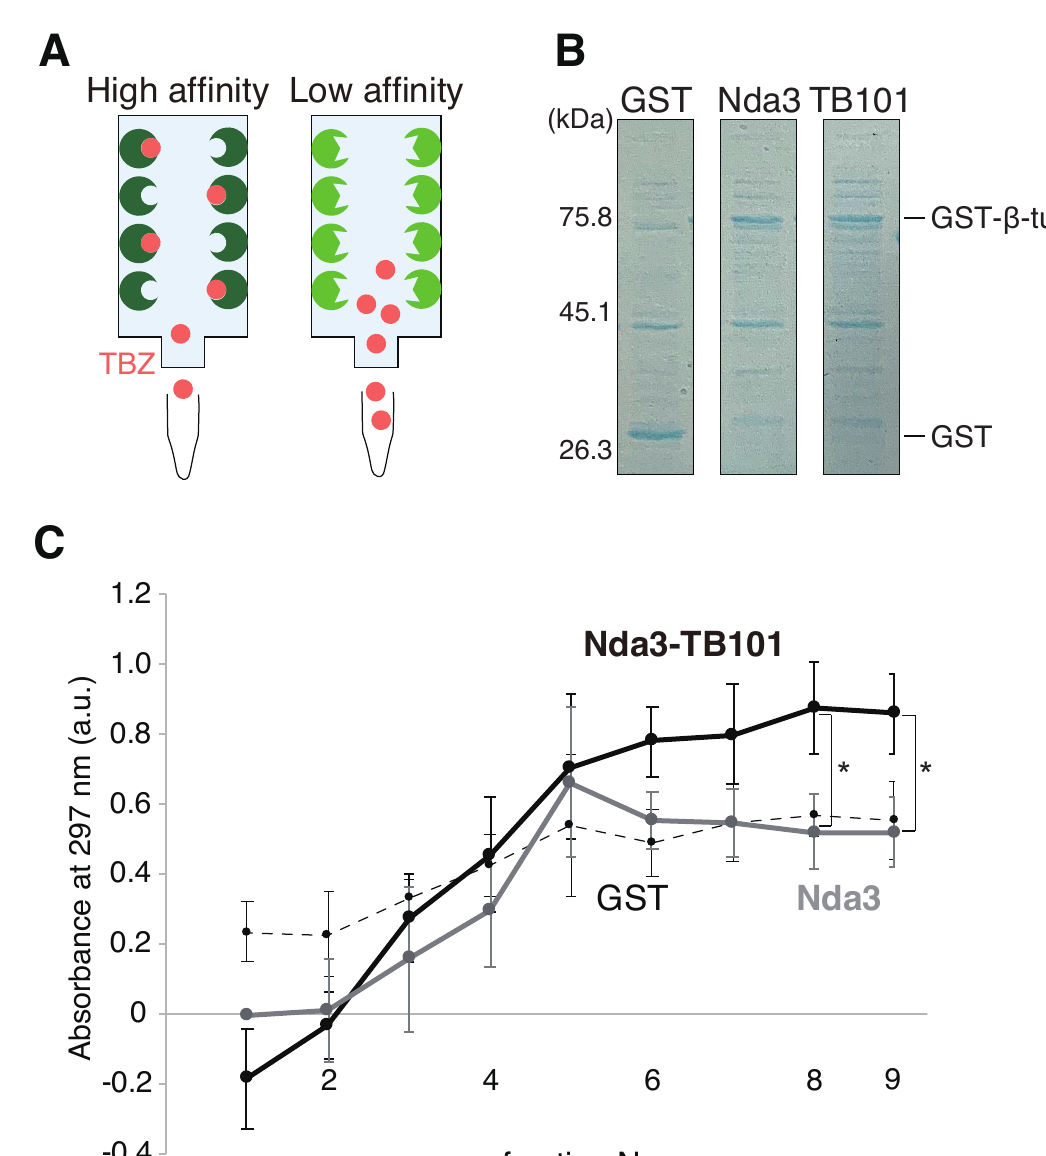
Figure 9. The Y50S mutation of β -tubulin reduces binding affinity to TBZ. ( A ) A diagram for the binding assays. Recom- binant β -tubulin proteins are immobilized in the column and a TBZ solution is applied. TBZ is to be efficiently captured in the column when the affinity between β -tubulin and TBZ is high whilst TBZ will flow through the column when the affinity is low. ( B ) Expression of recombinant proteins Nda3 (WT) and Nda3-TB101 was confirmed by SDS-PAGE followed by Coomassie staining. MW (left) is judged from a marker. ( C ) Sequentially collected fractions 1–9 were applied to measure absorbance at 297 nm (a.u.). Gray line, Nda3 (WT); black solid line, Nda3-TB101; dashed line, GST. Error bars, S.D., * p < 0.05 (0.043, fraction 8; 0.035, fraction 9) (Student’s t -test), n = 3